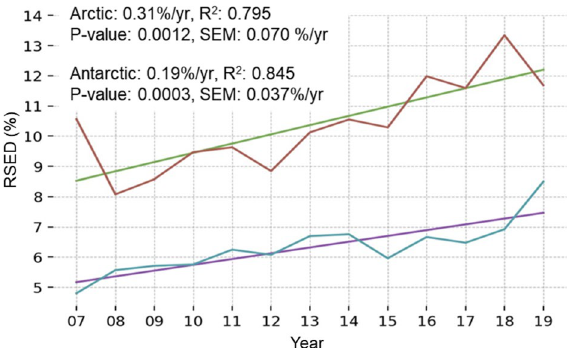
Figure 2. Yearly aggregated RSED for both polar regions between 2007 and 2019 with linear trends applied. The average dust extent increased by 0.31% and 0.19% per year for the Arctic and Antarctic, respectively. R 2 , P-Value and Standard Error of the Mean (SEM) indicate a strong linear correlation of the data.